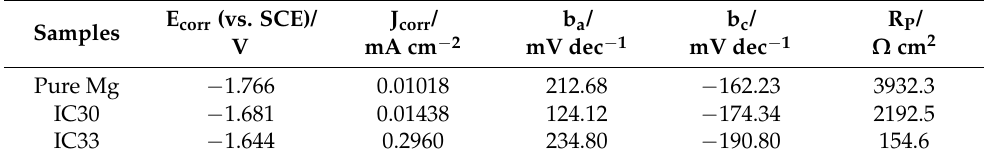
Figure 8. ( a ) Polarization curves and ( b ) anodic branches of the polarization curves for Mg-based anodes in 3.5% NaCl solution. Table 3. Relevant corrosion parameters of Mg-In-Ca alloy.